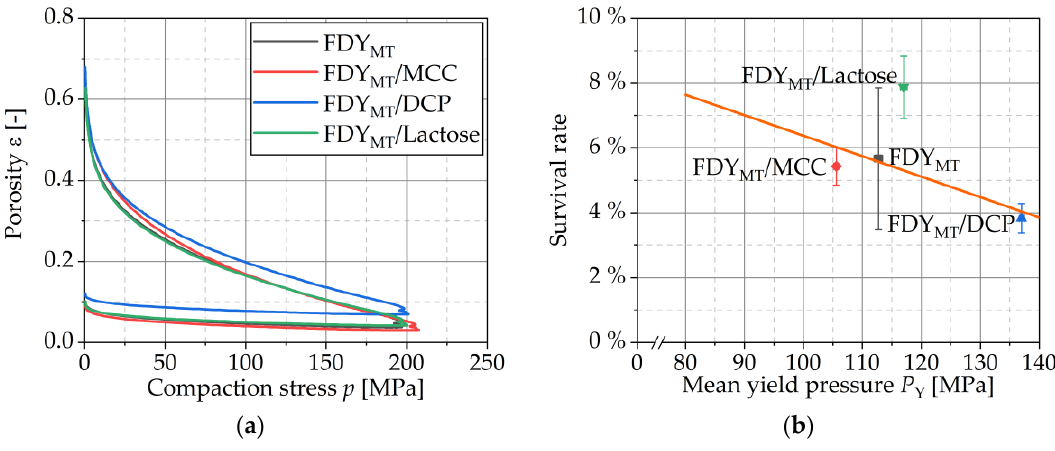
Figure 5. ( a ) In-die porosity profiles of pure FDY MT and FDY MT mixed with MCC, DCP and lactose. ( b ) Correlation of mean yield pressure of formulation and survival of cells during tableting with a compaction stress of 200 MPa. The R 2 of the linear regression is 0.220. Symbols represent means and error bars standard deviation; n = 3.